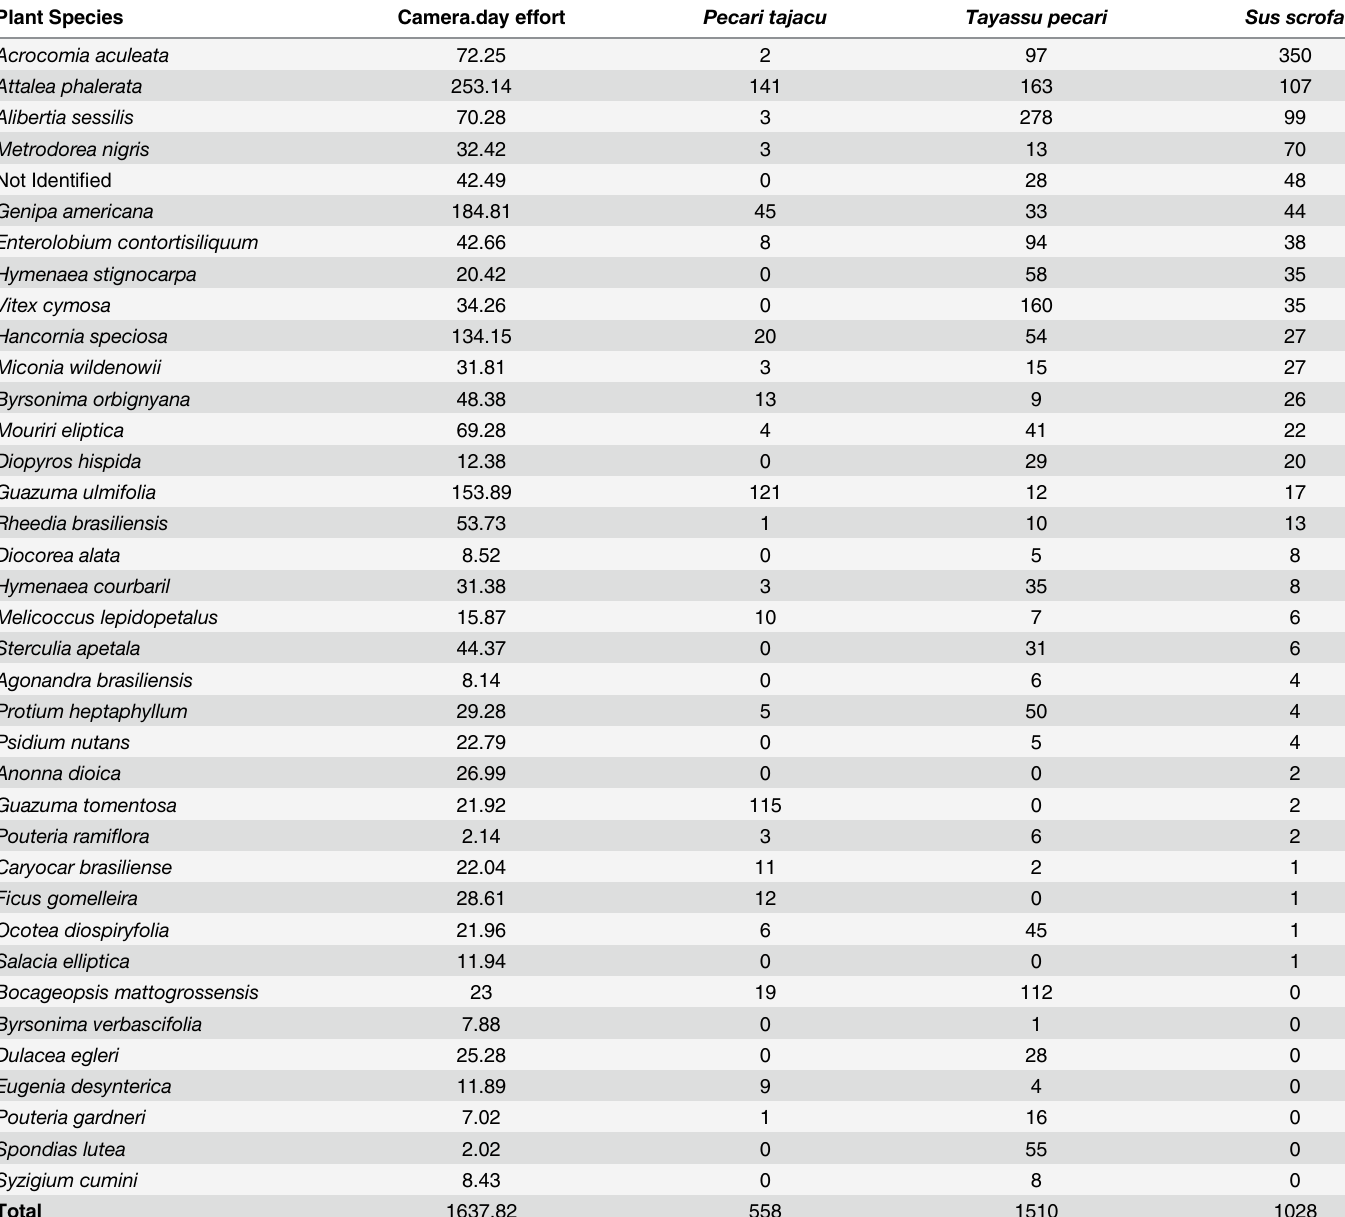
Table 1. Sampling effort and number of photos taken in fruiting trees visited by natives white-lipped peccaries ( Tayassu pecari ) and collared pec- caries ( Pecari tajacu ) and by an exotic feral pigs ( Sus scrofa ) in the Pantanal, Mato Grosso do Sul,